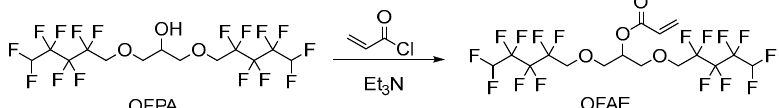
Figure 5. Synthesis route of monomeric OFAE.